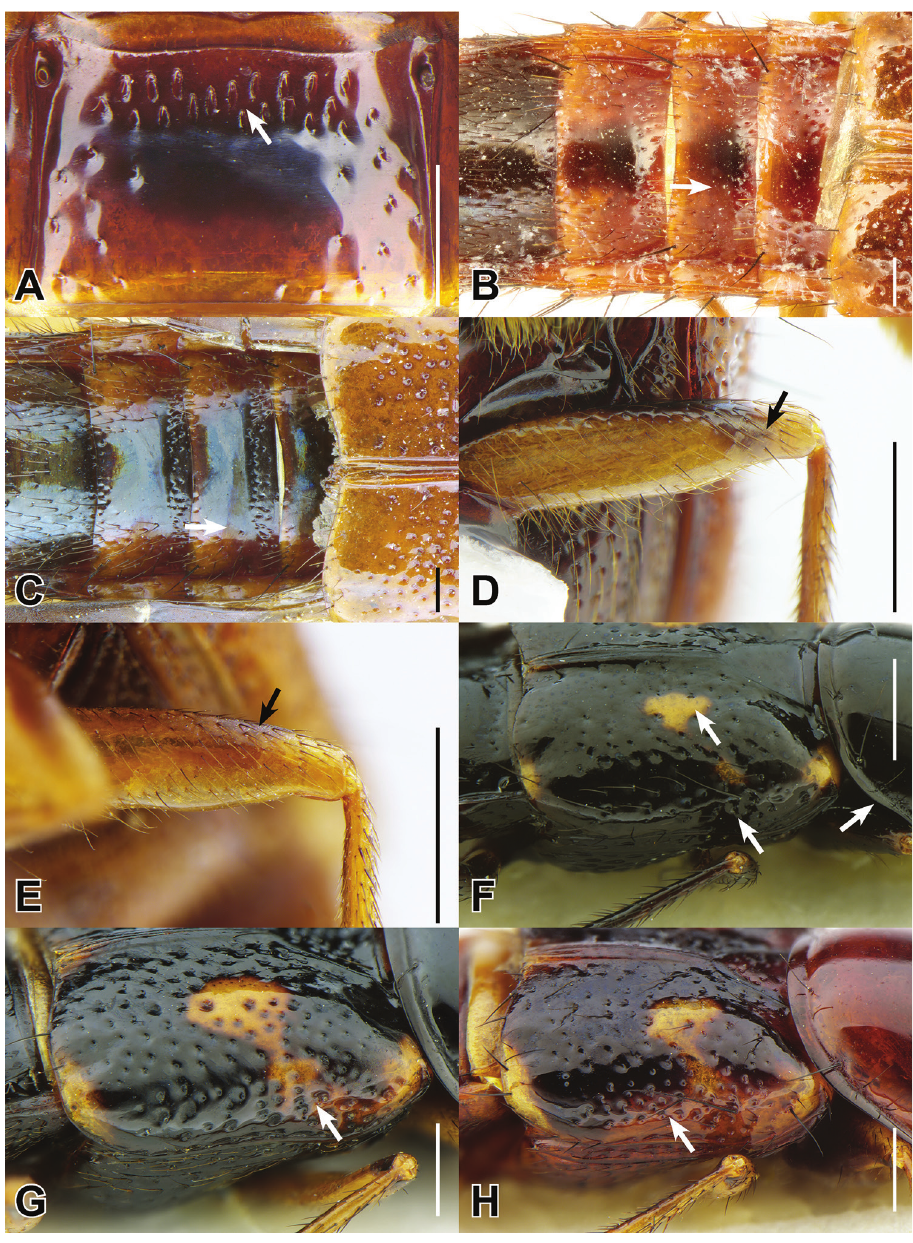
Figure 5. Abdominal tergite III: Bolitogyrus sepilok Brunke ( A ). Dorsal abdomen: B. elegantulus Yuan et al. ( B ) and B. carnifex (Fauvel) ( C ). Anterior face of mid-femur: B. elegantulus ( D ) and B. phukhieo Brunke ( E ). Lateral view of elytron: B. ornatipennis (Wendeler) ( F ), B. pictus Yuan et al. ( G ) and B. solo- dovnikovi Brunke ( H ). Scale bars: 0.25 mm ( A ), 0.5 mm ( B–H